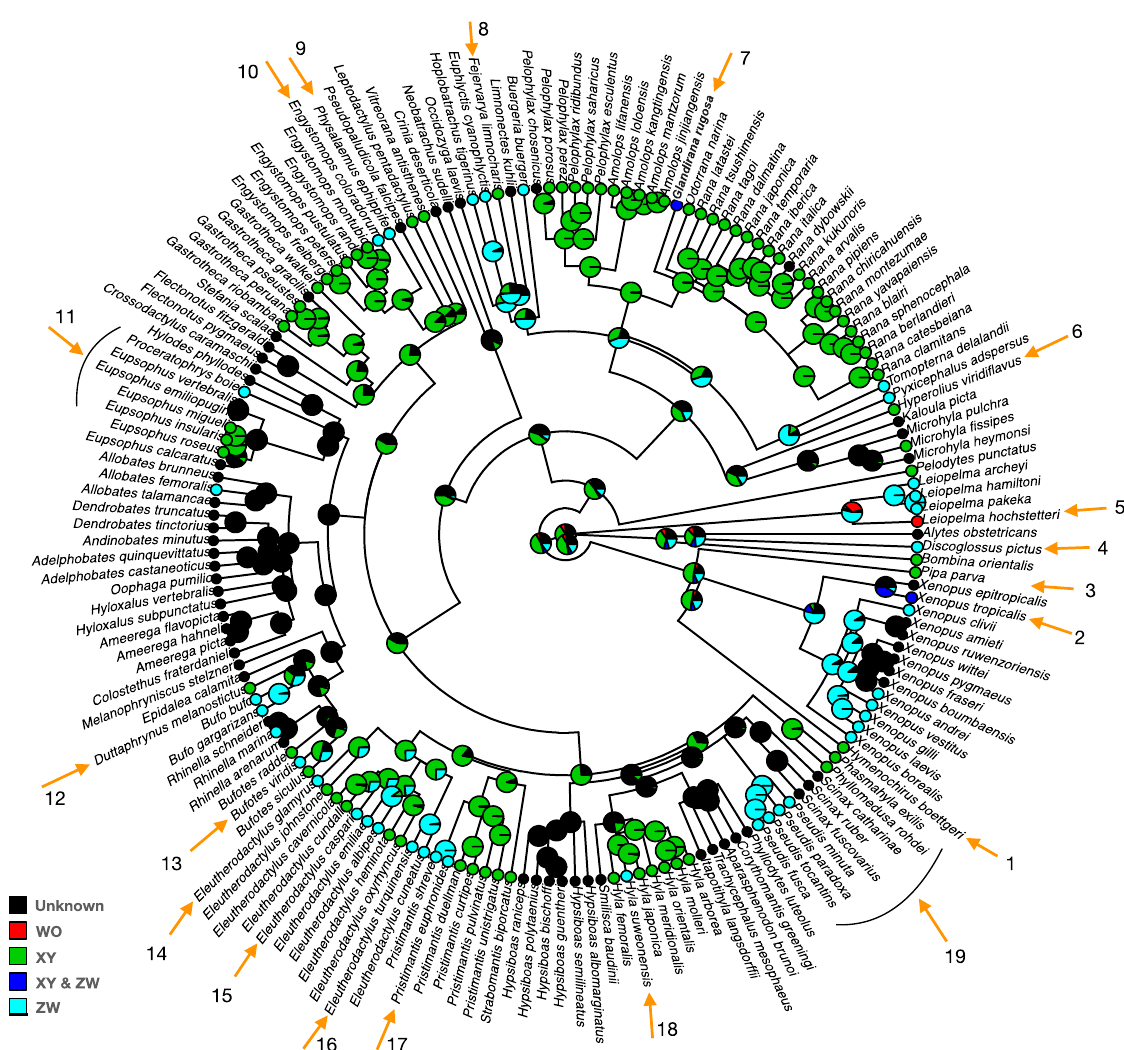
Figure 2. Distribution of various sex-determination systems along Anurans. The phylogenetic tree is obtained from http://www.timetree.org/, accessed on 5 February 2021 and the pattern of sex chromosome diversity and the ancestral status reconstruction were analyzed and visualized with the “Phytools” package in R (version 3.6.3), using a stochastic mapping approach with the ARD (all rates different matrix) transition rate model for discrete character traits [48,49]. Pie charts display the posterior probability of sex-determination systems on each node of the phylogenetic tree. Numbered arrows indicate transitions between sex-determination systems.